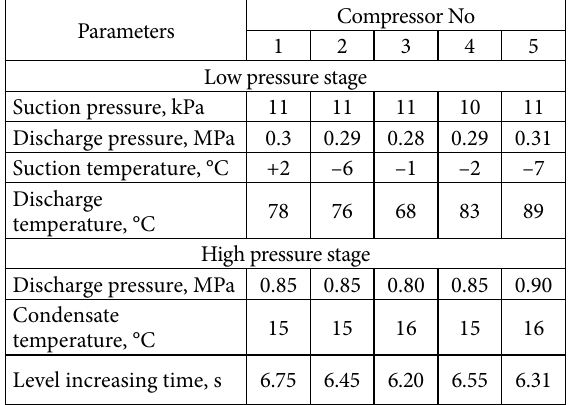
Table 2. Results of reliquefaction plant trial